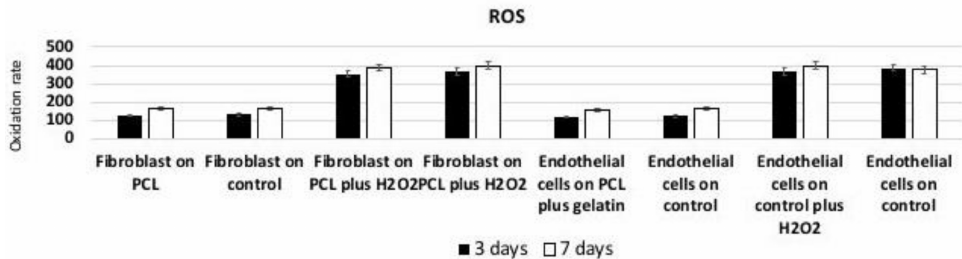
Figure 9. Reactive Oxygen Species (ROS) production of Fibroblast and endothelial cells seeded onto PCL, plastic cultures, PCL plus gelatin, plasticultures plus gelatin. Histograms show a slight time- dependent increase in metabolic activity in cells seeded onto both surfaces. Results are expressed as fluorescent arbitrary units per second confirm no production of pathological concentration of